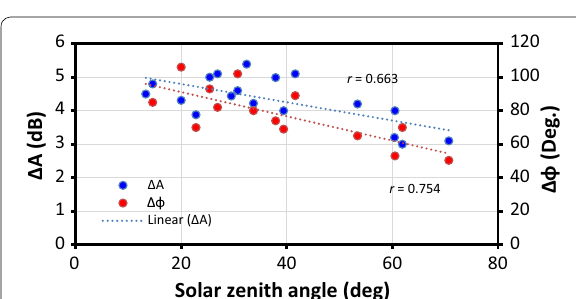
Fig. 6 Variation of amplitude and phase perturbations to the NLK signal against the absolute values of solar zenith angle for flares occurring in the narrow range of class M 1.0– M